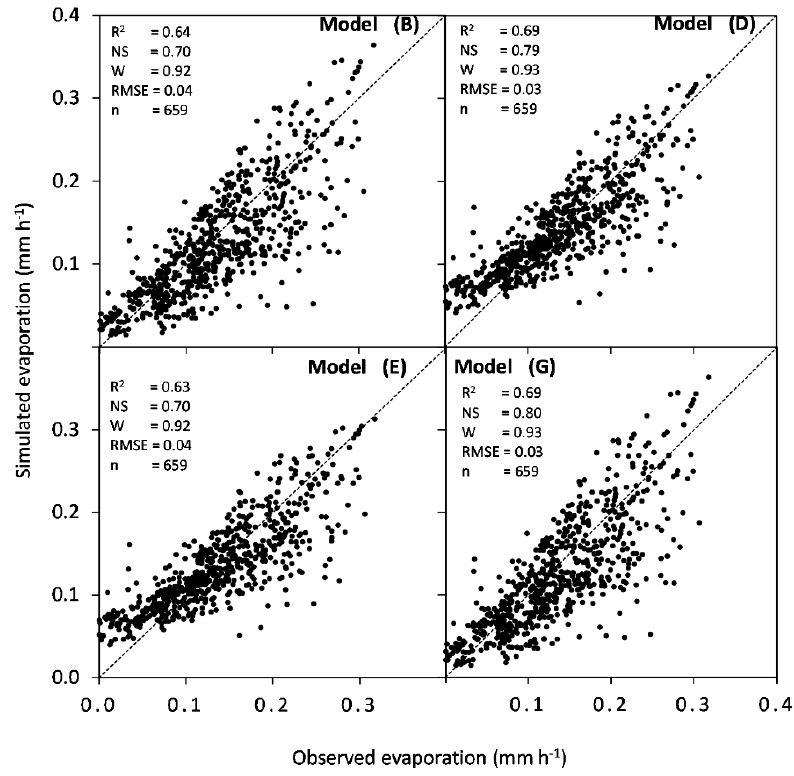
Figure 12. Relationship between measured and estimated E with the generalized form of the mass transfer models.